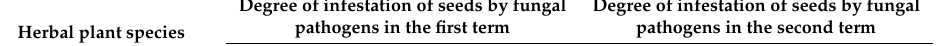
Table 3. The influence of the method of obtaining plant extracts on the degree of seed infestation by fungal pathogens (%). Degree of infestation of seeds by fungal Degree of infestation of seeds by fungal pathogens in the first term pathogens in the second term Herbal plant species Macerate Decoction Macerate Decoction Levisticum o ffi cinale